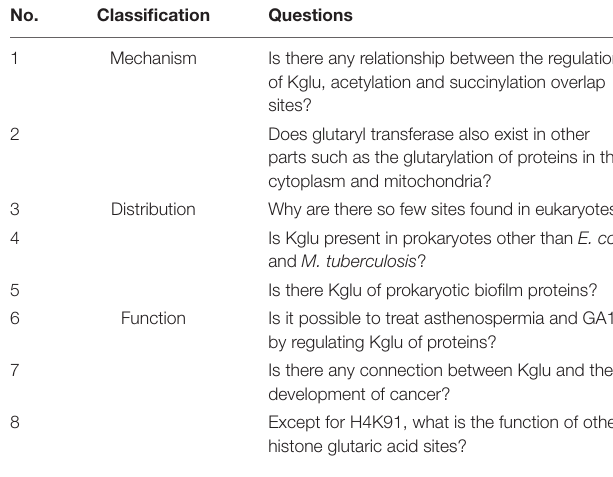
TABLE 4 | Scientific questions for future studies about